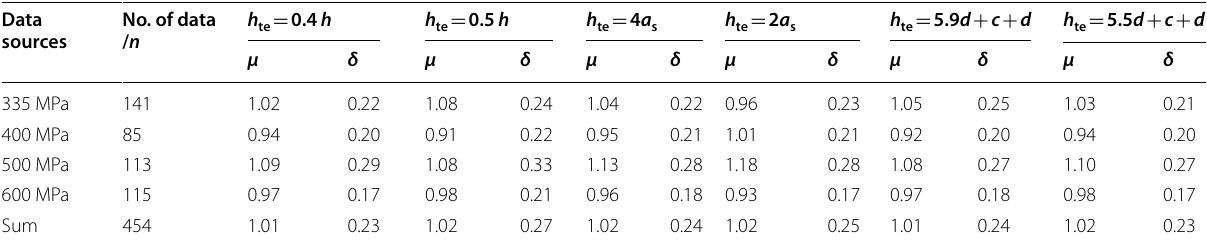
Table 13 Comparison results of w t max from RC beams with 335 MPa–600 MPa steel bars with w c1 max by the proposed methods. Data